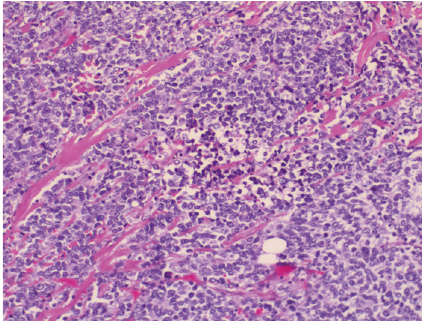
Figure 10: Immunohistochemistry shows positive nuclear staining of the tumor cells for myogenin (X100).